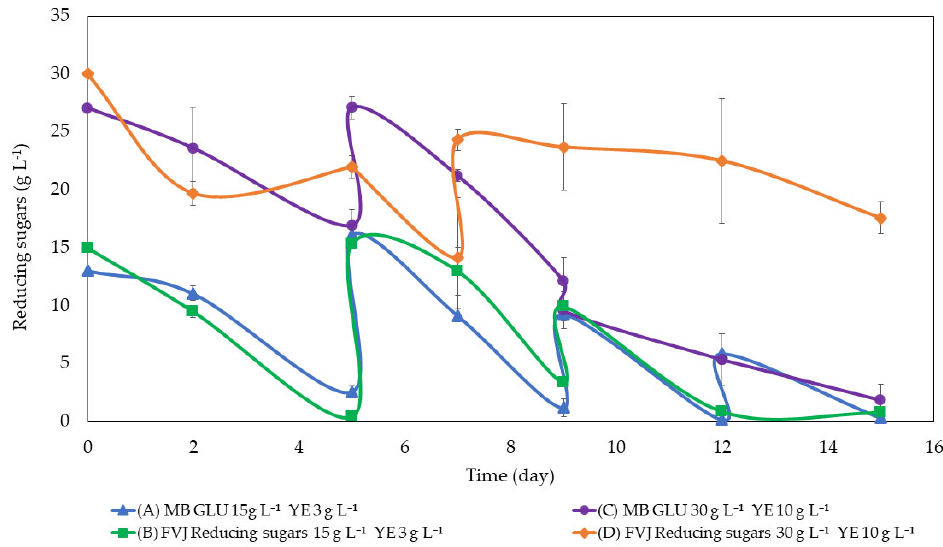
Figure 1. Reducing sugar consumption expressed as g L − 1 of glucose-reducing sugar in each assay, before and after adding fresh medium to the bottles. MB: modified Bristol; GLU: glucose; FVJ: fruit and vegetable juices; YE: yeast extract. Error bars represent SD (n = 3).